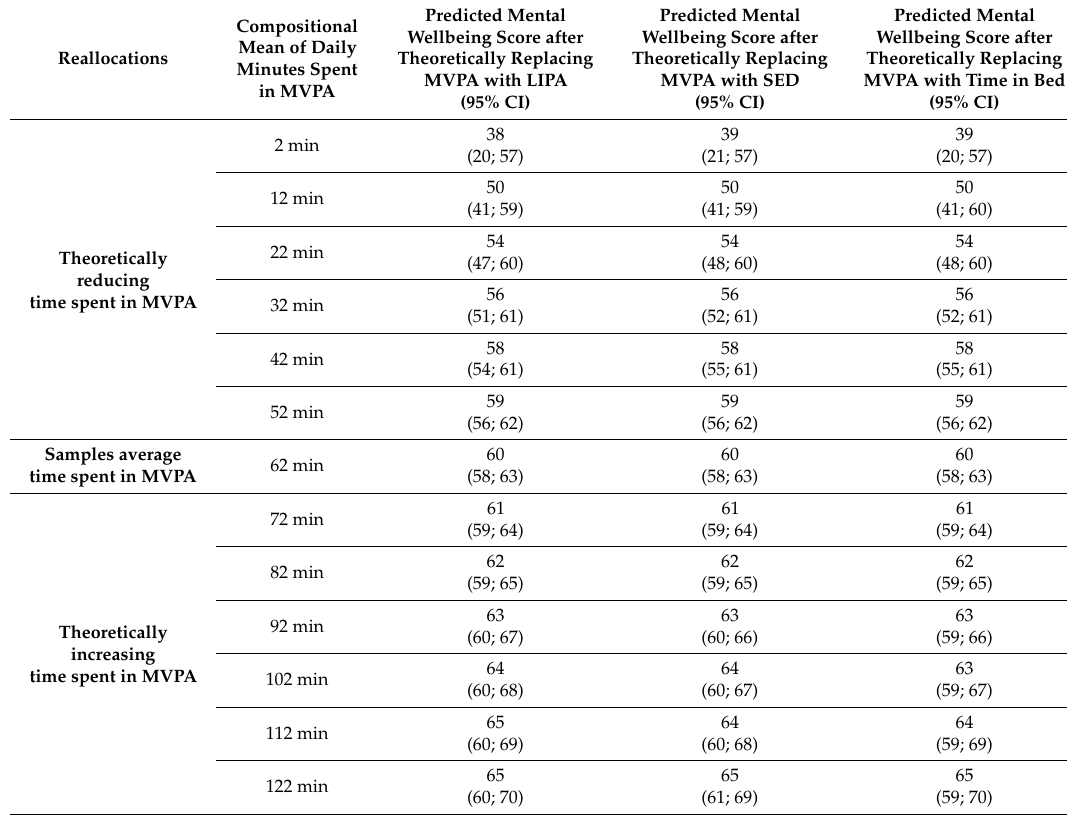
Table A6. Predicted mental wellbeing scores and 95% CI for theoretically altered 24 h movement compositions. Time between MVPA and remaining behaviors were reallocated in steps of 10 minutes (one-for-one reallocations).